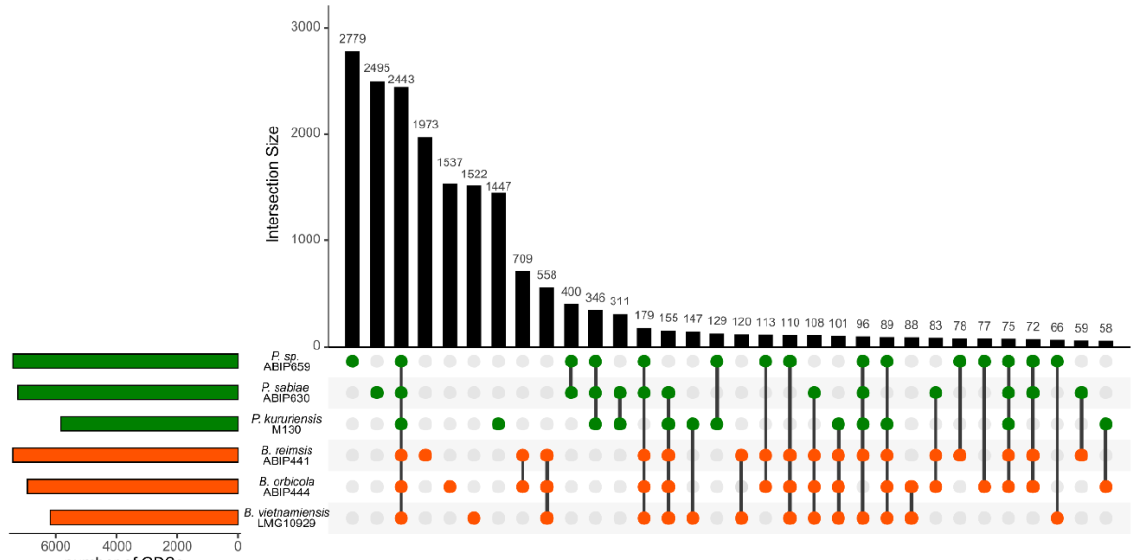
Figure 3 - UpSet plot of gene conservation between six Burkholderia s.l. strains. Single dots are representative of the specific genome of each strain. Linked dots represent the conserved genes among the connected strains. All combinations totaling less than 50 conserved genes are not shown. Gene duplicates were excluded from this